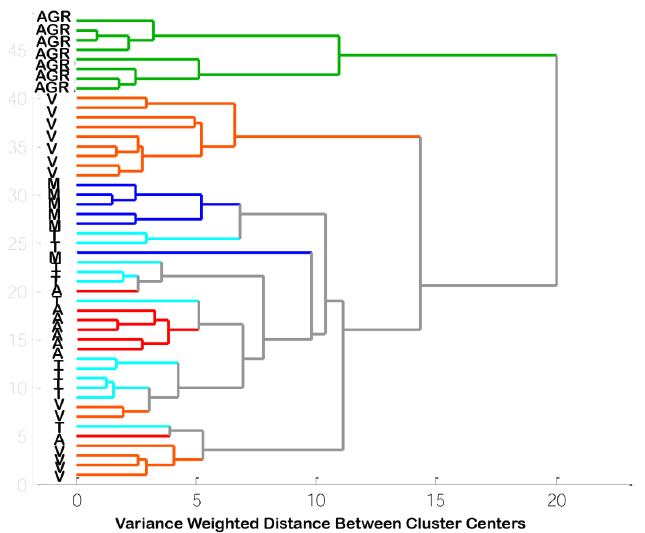
Figure 1. Dendrograms of five taxonomical different bivalve species based on element content (AGR- Agropectin irradians , A- Anadara broughtonii , M- Mizuhopecten yessoensis , T- Tegillarca granosa , V- Venerupis philippinarum ).